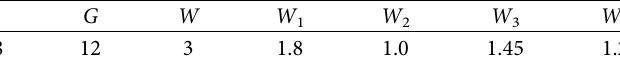
Figure 1: (a) Geometry of antenna; (b) front view of antenna geometry; (c) bottom view of antenna geometry. Table 1: Dimensions of front of antenna.